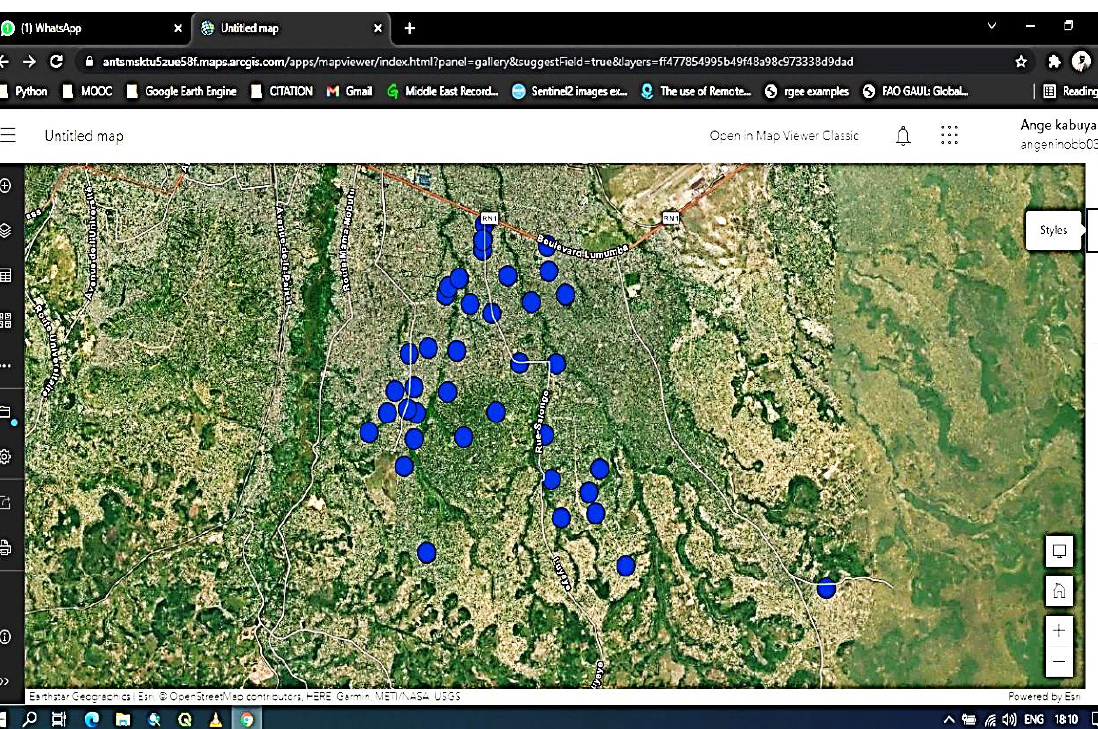
Figure 26. Map generated using qGis (Professional interface) (Source: Authors).